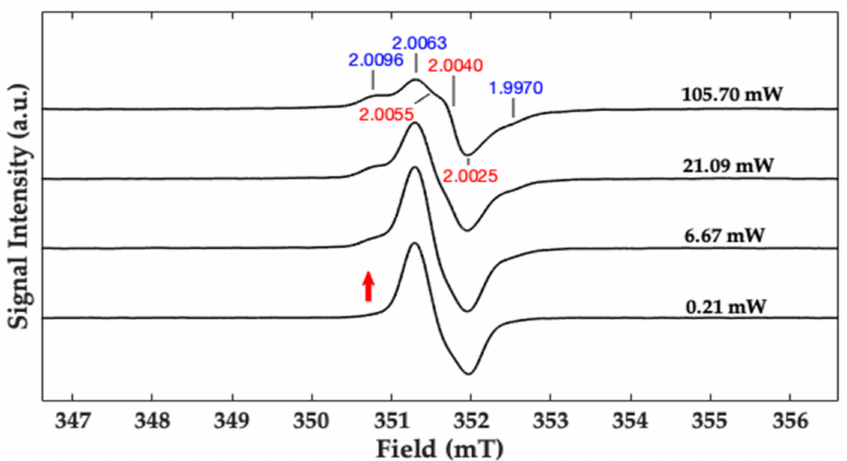
Figure 5. Room temperature (T = 298 K) X-band ( ν = 9.86 GHz) EPR spectra of HGAm at pH 7.1 with a laccase:substrate molar ratio 1:1000 recorded at variable microwave power values.